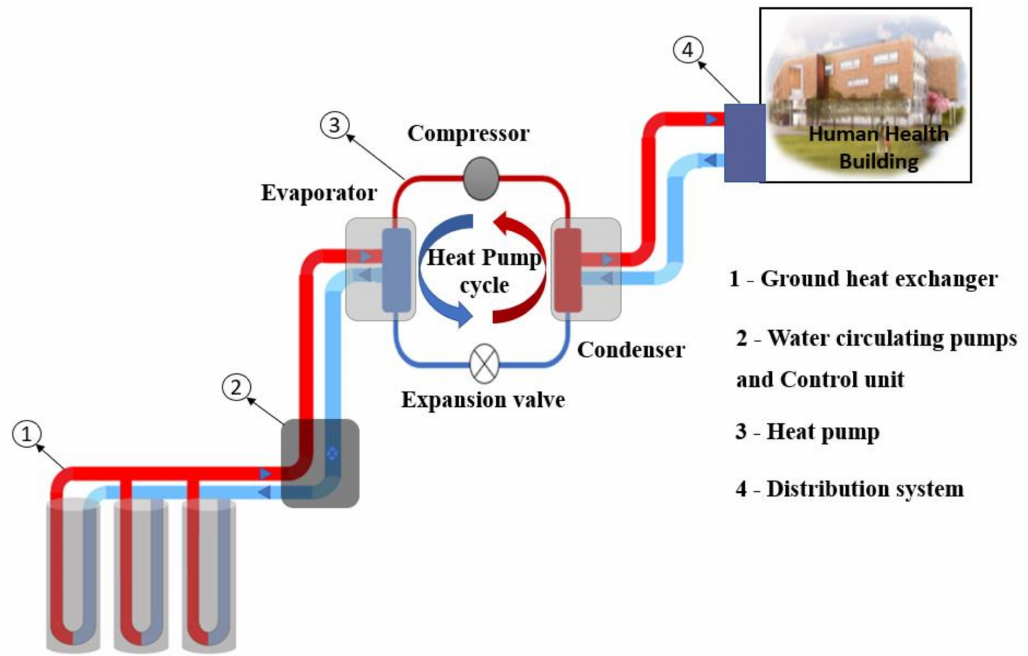
Figure 6. Schematic diagram of Oakland University’s